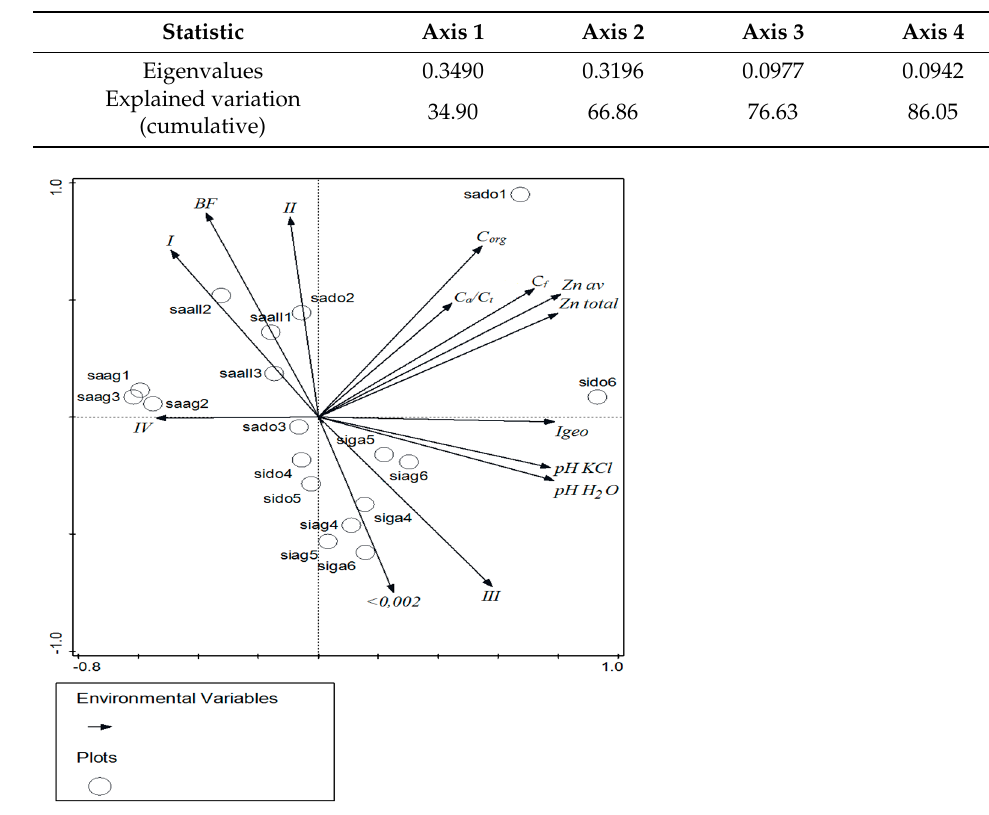
Table 4. Summary of the Zn results in PCA.